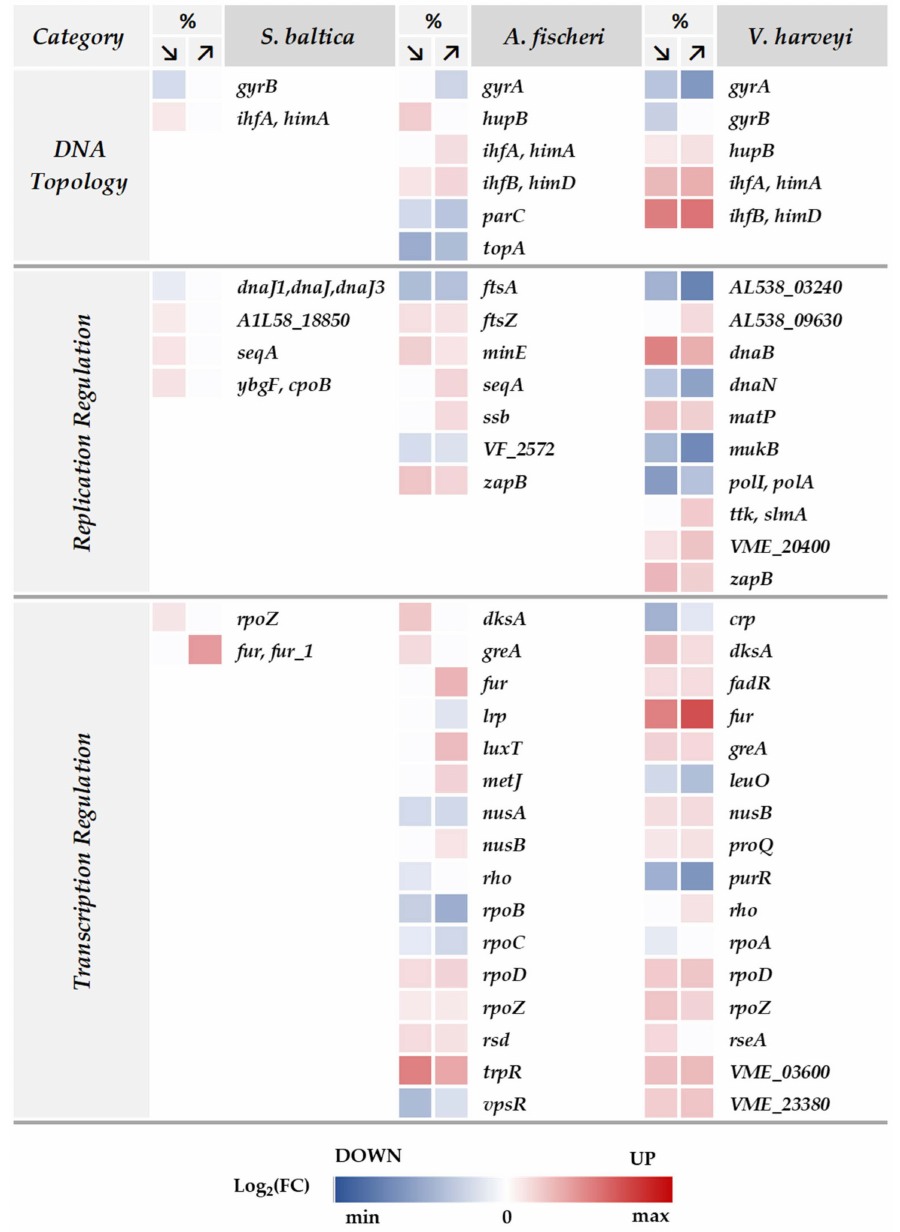
Figure 6. Heatmaps of the abundance of selected nucleic acid-binding, replication- and transcription- related proteins in S. baltica , A. fischeri , and V. harveyi , following low- and high-salinity stress. In the header, upwards- and downwards-pointing arrows indicate low- and high-salinity conditions, respectively. The hue of blue or red colors indicates the change in level (log 2 -transformed fold change (FC) values) of selected proteins relative to optimal salinity; the corresponding gene names are used to designate proteins. Exact protein fold change values can be found in Supplementary Table